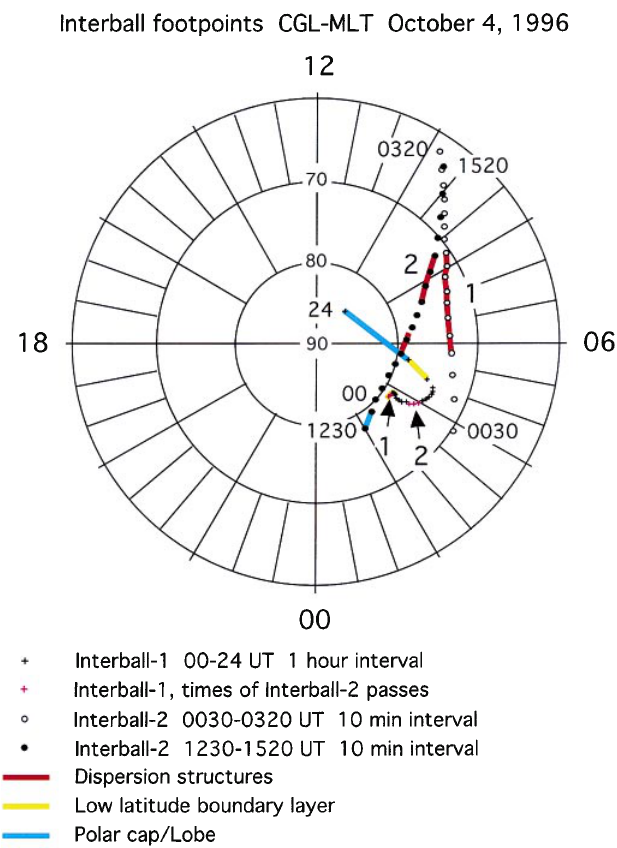
Fig. 12. Footpoints of the orbits of the two Interball satellites on October